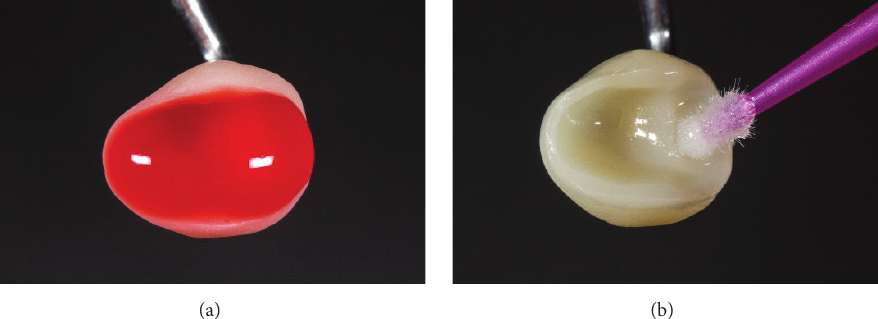
Figure 11: Conditioning of the ceramic restoration using 5% hydrofluoric (Vita Ceramics Etch, Vita Zahnfabrik, Bad S¨ackingen, Germany) acid and a silane coupling agent (Calibra Silane, Dentsply DeTrey, Konstanz, Germany).